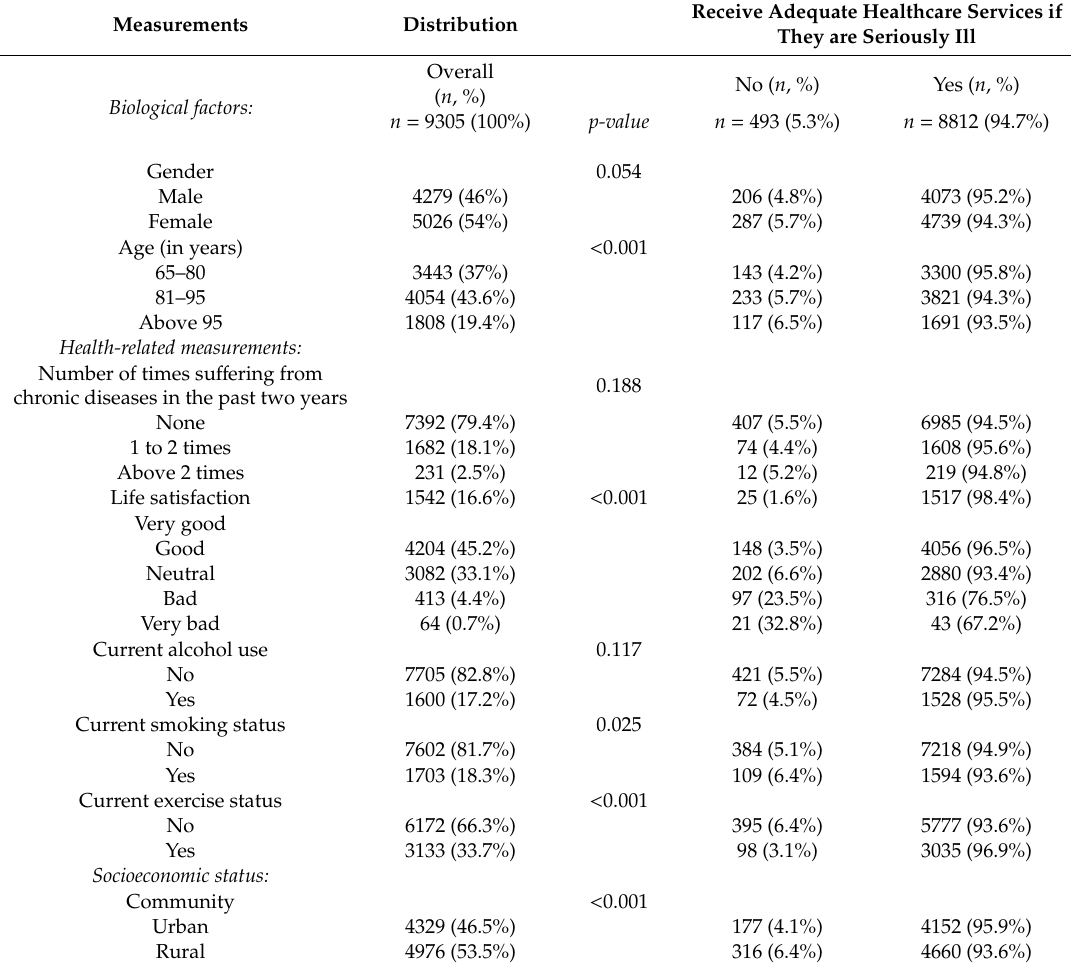
Table 2. Descriptive statistics of the final study sample: Chinese Longitudinal Healthy Longevity Survey (CLHLS), 2012–2014 ( n =